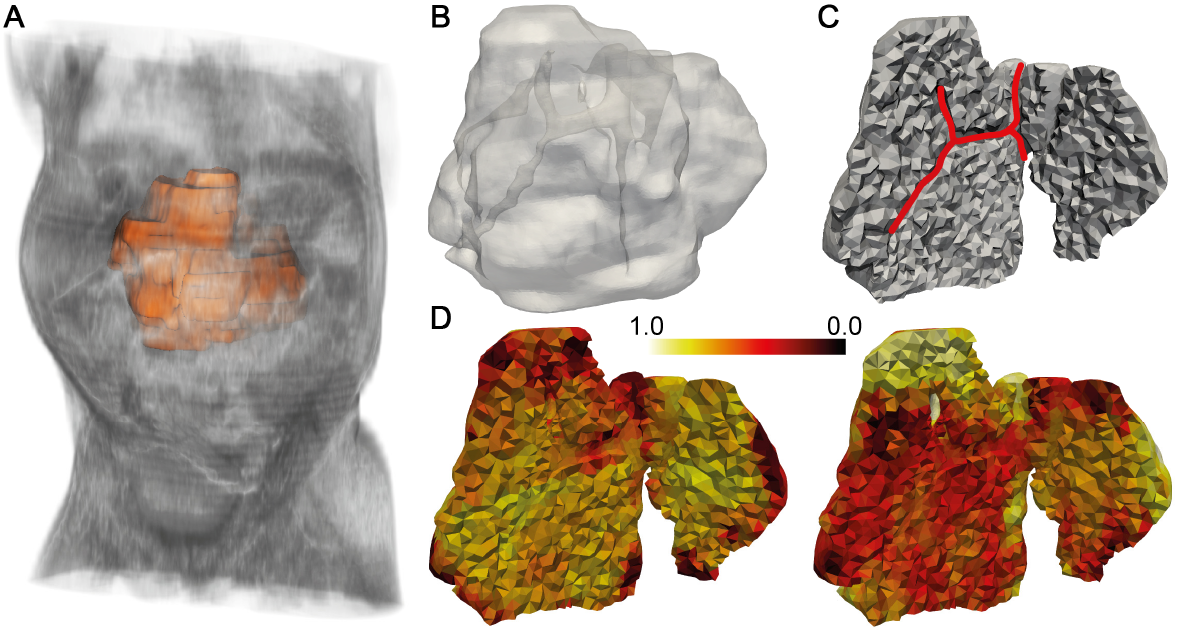
Figure 5. Application of the im2mesh library to one of the cases from the PRIMAGE dataset; ( A ) reconstruction of the tumour and the abdominal region of the patient using 3D Slicer (whole stack of 50 slices); ( B ) surface mesh of the tumour generated using our library from the 17 slices containing the tumour. Through the semi-transparent surface, the mesenteric artery and some of its branches can be seen passing through the tumour; ( C ) volumetric mesh of the tumour with the aforemen- tioned vessels highlighted in red; ( D ) normalized cellularity (left) and vascularization (right) maps interpolated from DWI and DCE sequences to the volumetric mesh presented in ( C ).